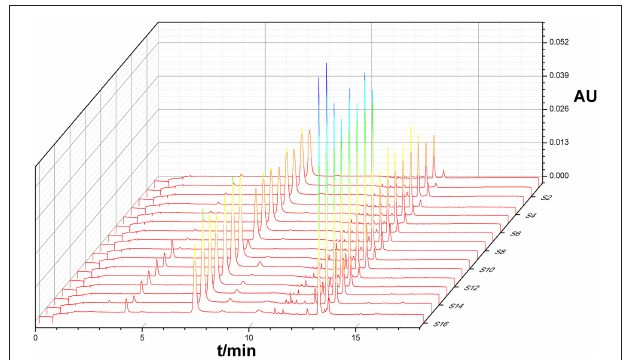
FIGURE 1 | UPLC fingerprints recorded for extracts from several batches.